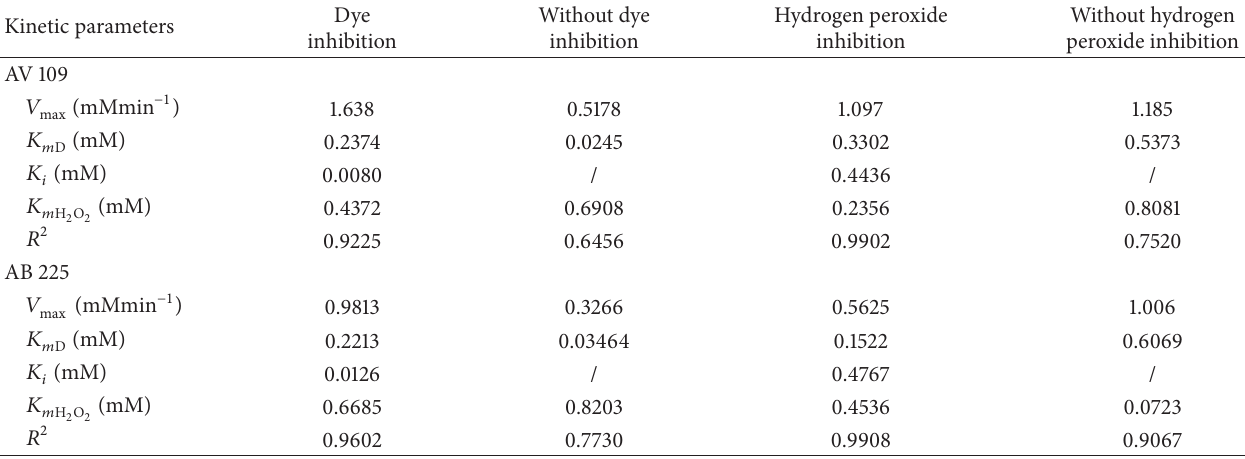
Table 4: Best fit of kinetic parameters obtained for the H model considering inhibition with substrates and without inhibition. Kinetic parameters